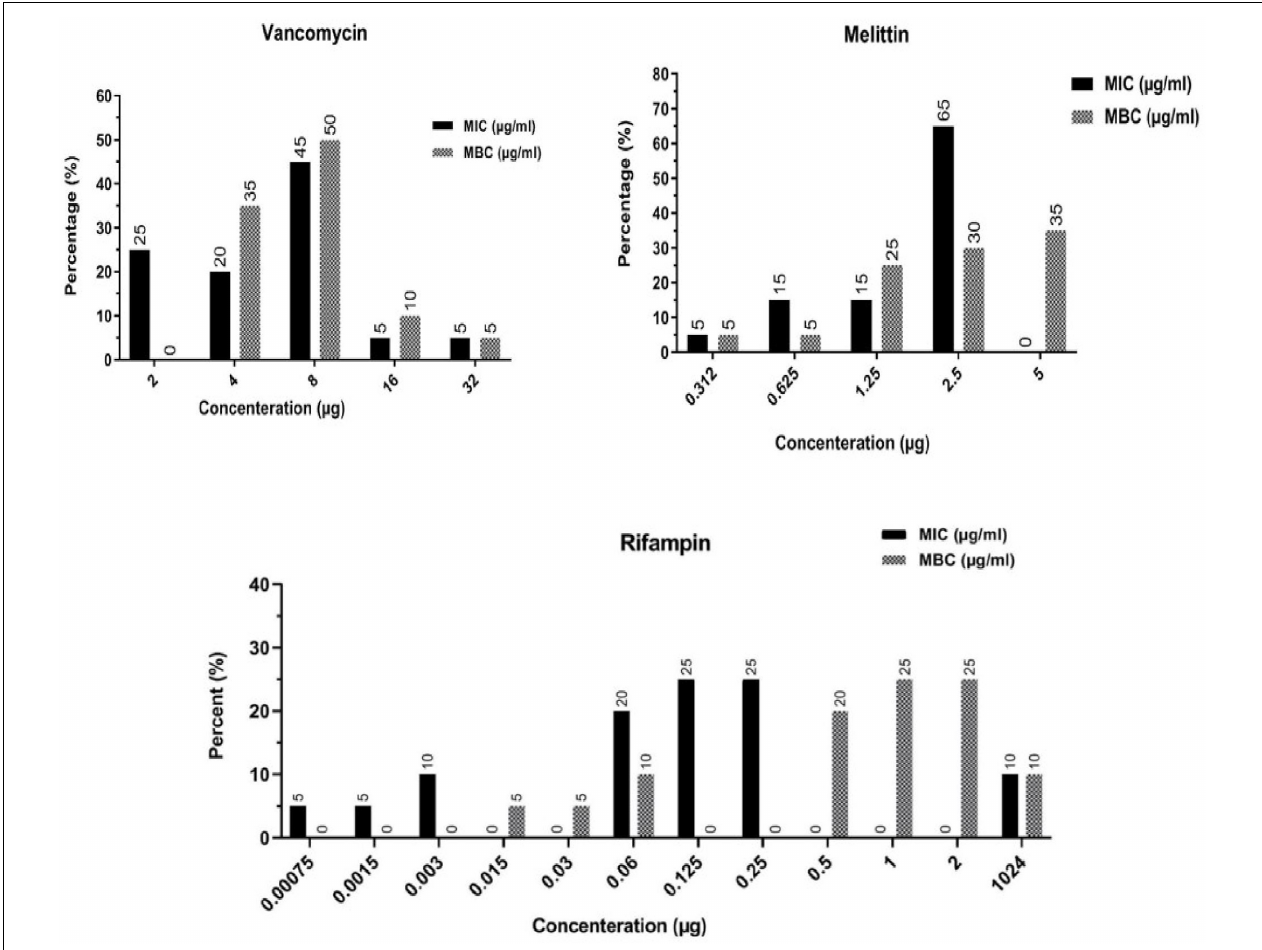
FIGURE 2 | Frequency distribution of MIC and MBC in Staphylococcus epidermidis isolates toward vancomycin, rifampin, and melittin. MIC, Minimum inhibitory concentration; MBC, minimum bactericidal concentration.